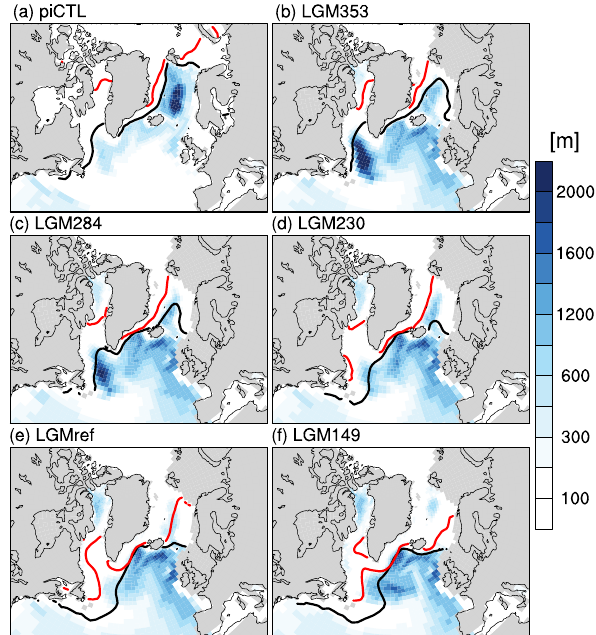
Figure 9. Climatological mean winter (JFM) mixed layer depth (shading), winter (JFM) ice edge (30% coverage, black contour) and summer ice edge (30% coverage, red